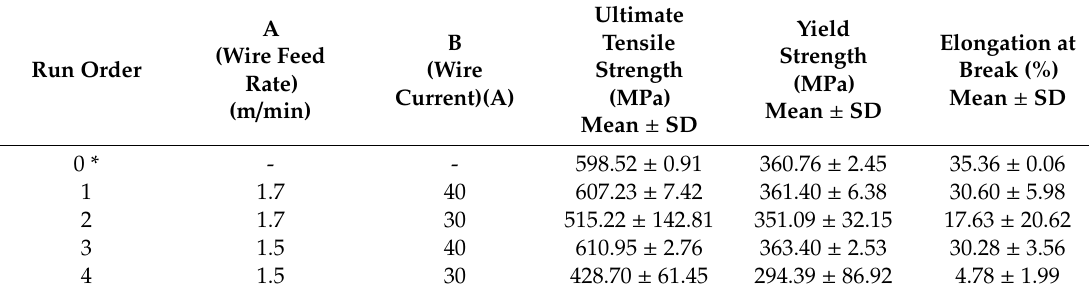
Table 7. Tensile strength results according to the experimental